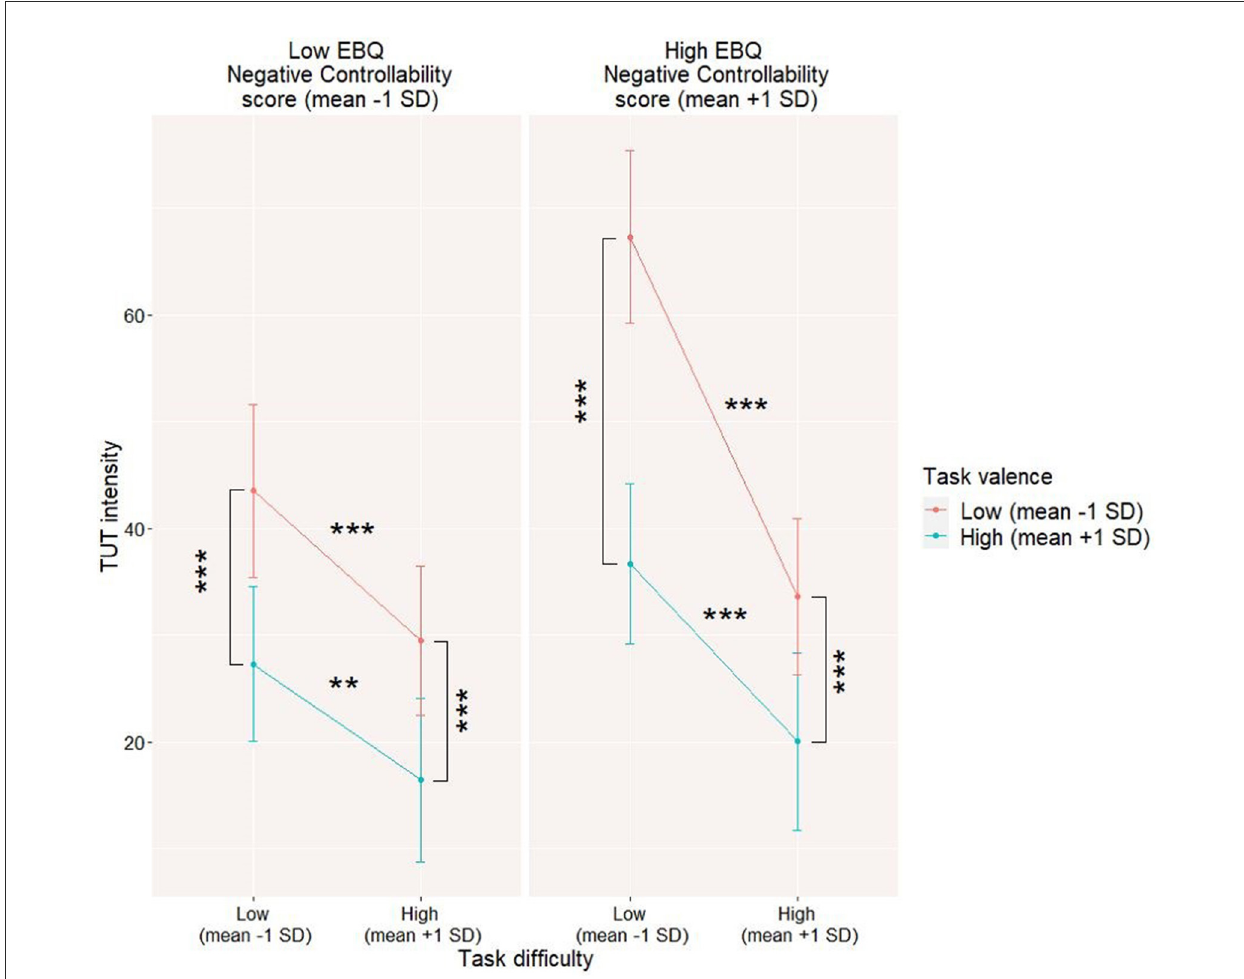
FIGURE5 Emotion Beliefs Questionnaire (EBQ)—negative emotions controllability moderating level 1 interaction between thought control and task difficulty on task-unrelated thoughts (TUT) level. The data for the moderation model were visualized by computing slopes for high (mean + 1SD) and low (mean-1SD) levels of each predictor and moderator. ** p < 0.01; *** p <